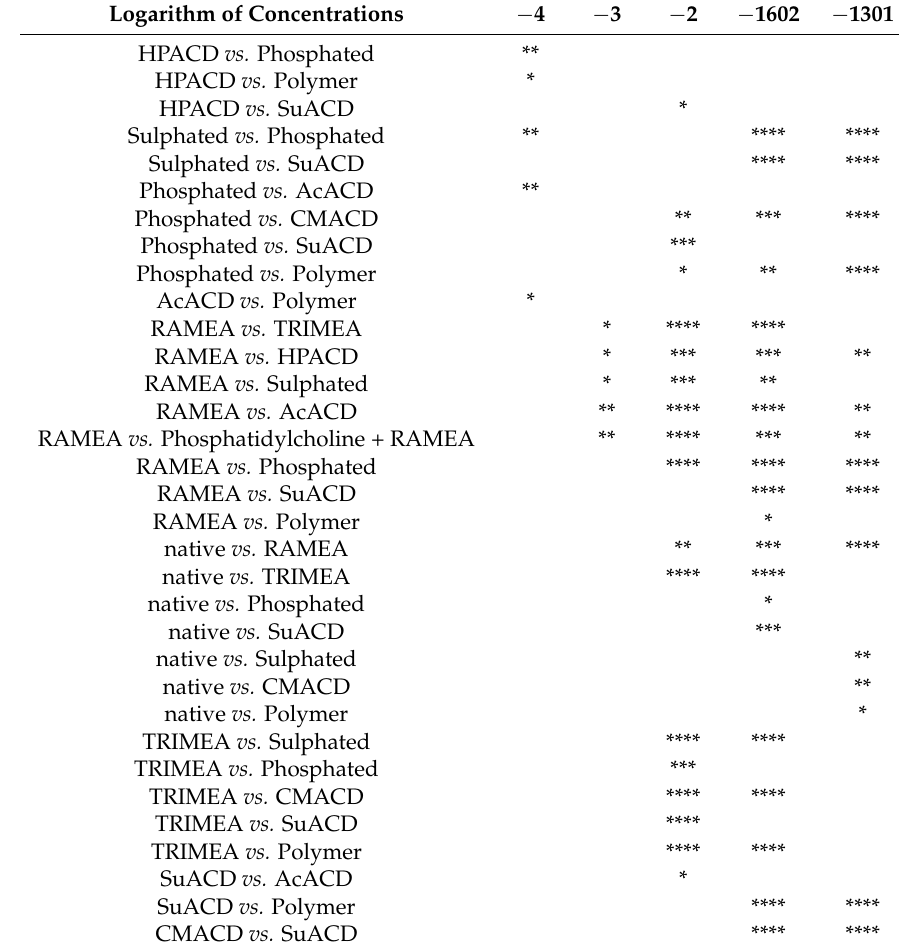
Table 3. Comparison of cell viability values among the groups treated with different α -CD derivatives (the number of asterisks indicates the level of statistical significance, p < 0.005 (*), p < 0.001